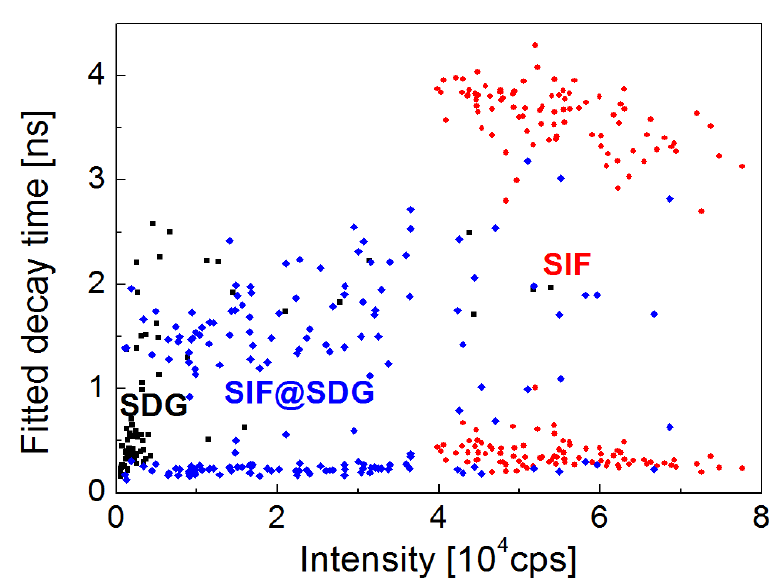
Figure 5. Correlation plot showing fluorescence intensities of PCP emission obtained by integrating all measured transient curves as a function of decay times fitted to these transients. Data for PCP on SIF (red), PCP on SDG (black), and PCP on SDG@SIF (blue) are shown. The excitation wavelength was 485 nm.